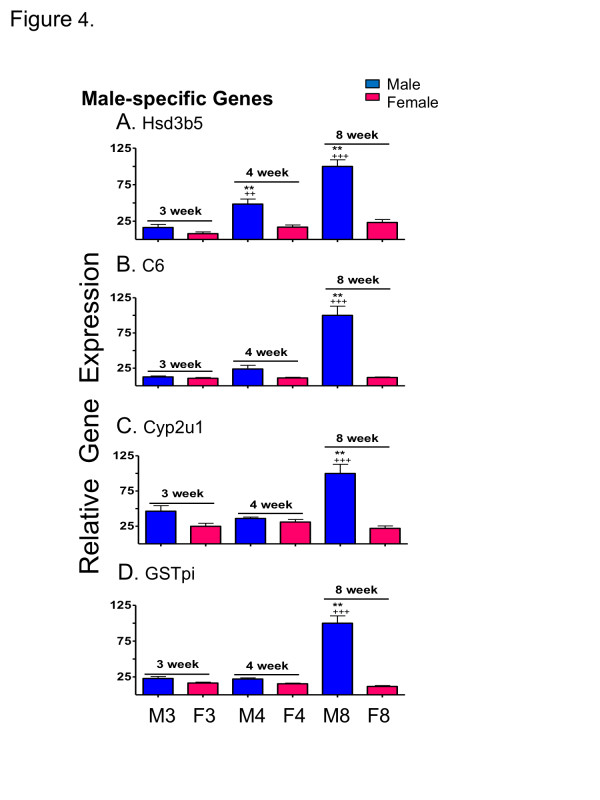
qPCR analysis of male-specific genes. qPCR analysis of relative RNA levels in male (M) and female (F) livers at 3, 4 and 8 wk, as marked at the bottom. Data shown for the four indicated adult male-specific genes are normalized to the 18S RNA of each sample, and based on n = 9-10 individuals per group (mean ± SEM). Statistical analysis (two-way ANOVA with Bonferroni post tests) was as follows: * p < 0.01, and ** p < 0.001, for male vs. female comparisons at each age; + p < 0.05, ++ p < 0.01, and +++ p < 0.001, for 4 wk vs. 3 wk, and for 8 wk vs. 4 wk comparisons within each sex. Very similar results were obtained by microarray analysis (Additional file 8).